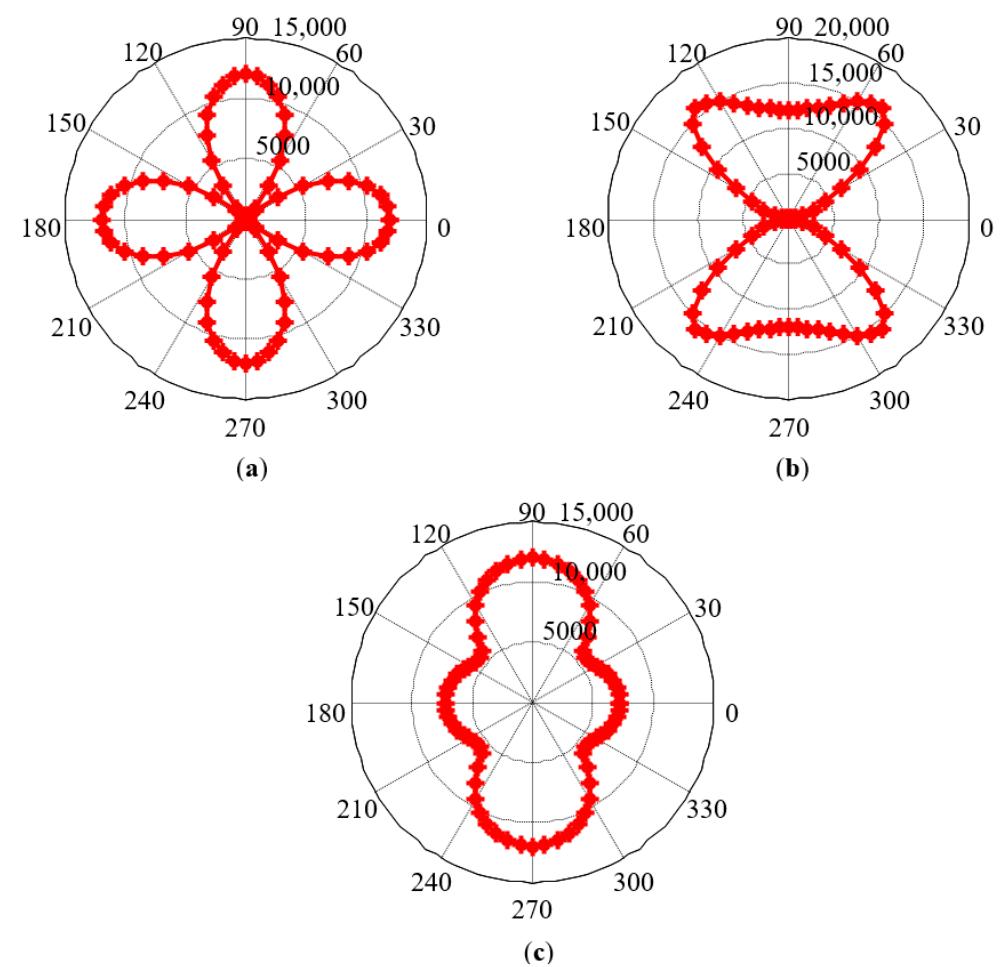
Figure 8. Simulation results of MCE under the condition of the increasing magnetic field strength: ( a ) grain orientation g 1 ; ( b ) grain orientation g 2 ; ( c ) grain orientation 60% g 1 + 40% g 2 .